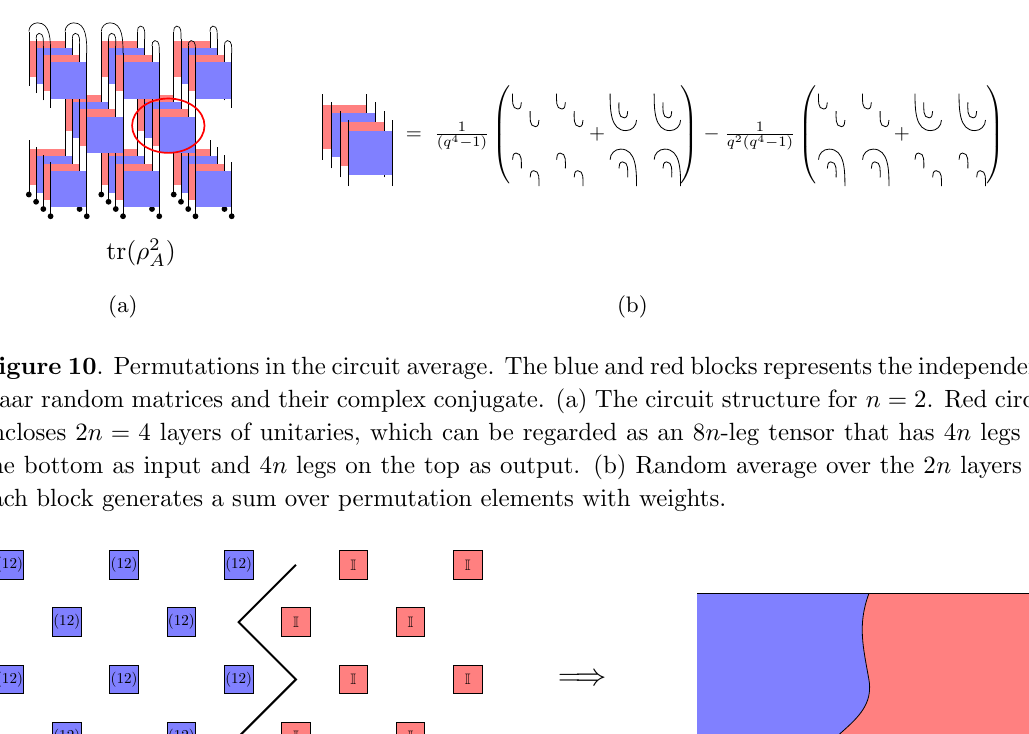
on the subsystem B respectively. The domain wall is a twist between them, inserted at the entanglement cut. If the spins in the left domain are all (cid:27) 1 and those in the right domain (cid:27) 2 , then the domain wall is a permutation (cid:28) = (cid:27) (cid:0) 1 (cid:27) 2 . In a general tensor network, 1